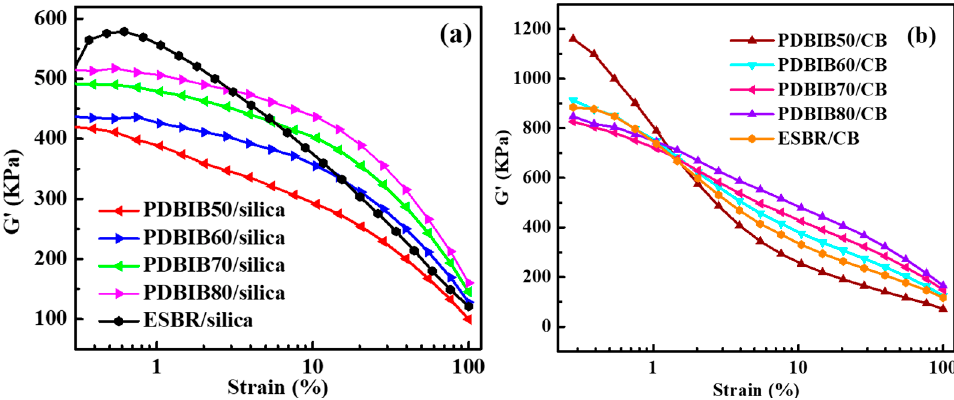
Figure 7. Strain dependence of storage modulus ( a ) PDBIB/silica and ESBR/silica, ( b ) PDBIB/CB, and ESBR/CB compounds.